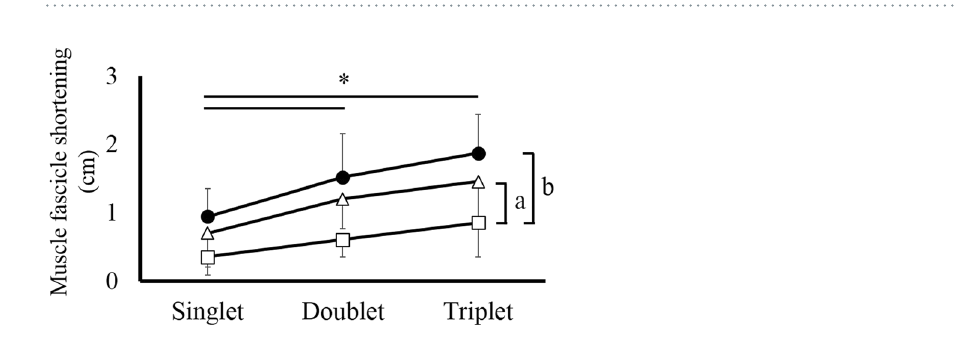
Figure 1. Mean twitch torque among joint angles and conditions. Mean twitch torque ± SD were plotted against twitch contraction at a given joint angle: DF20, white squares; PF0, white triangles; PF20, black circles. (a) Significant difference between DF20 and PF0 ( P < 0.05). (b) Significant difference between DF20 and PF20 ( P < 0.05). (c) Significant difference between PF0 and PF20 ( P < 0.05). * Significant difference among conditions in DF20 ( P < 0.05); # Significant difference among conditions in PF0 ( P < 0.05); † Significant difference among conditions in PF20 ( P < 0.05).